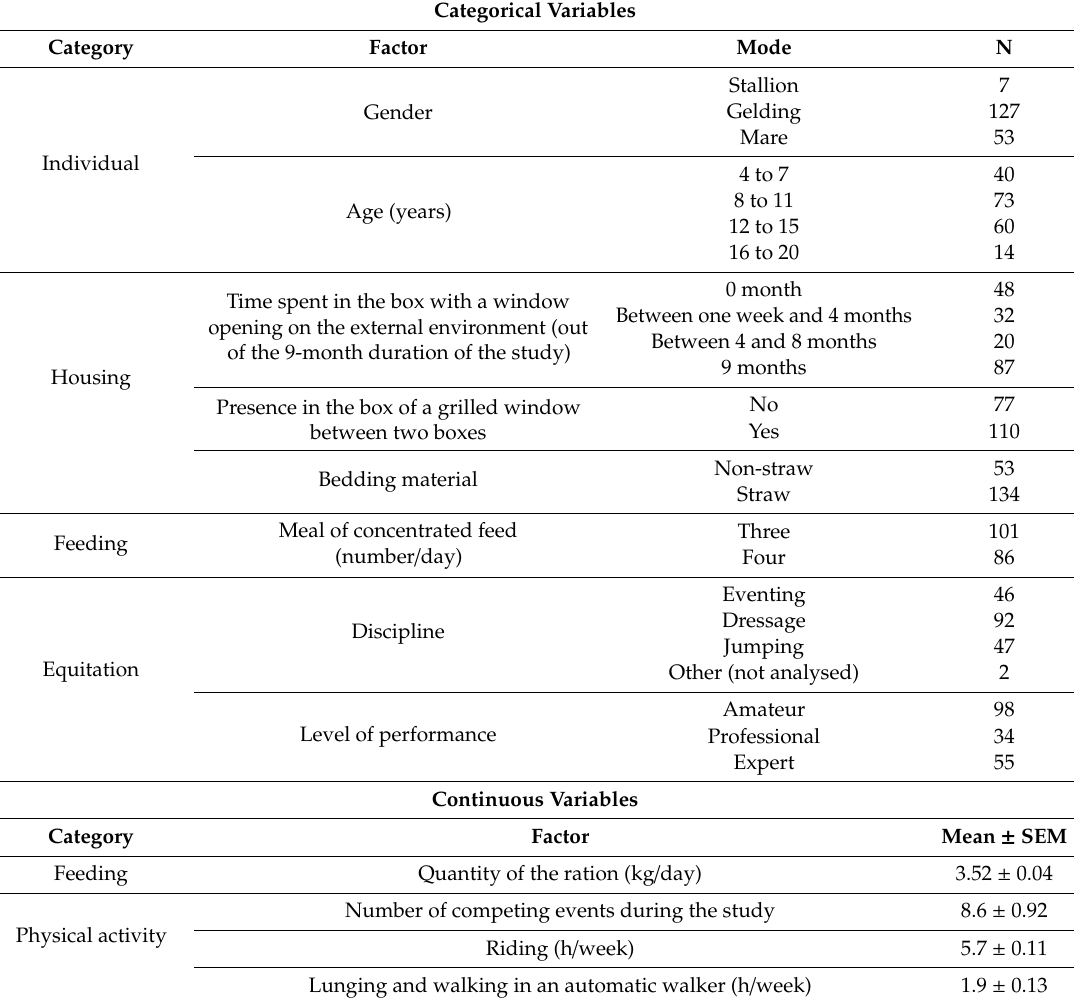
Table 1. Description of the 12 factors included in the analysis. The number of individuals (N) for categorical variables and the mean along with standard error (mean ± SEM) for continuous variables are